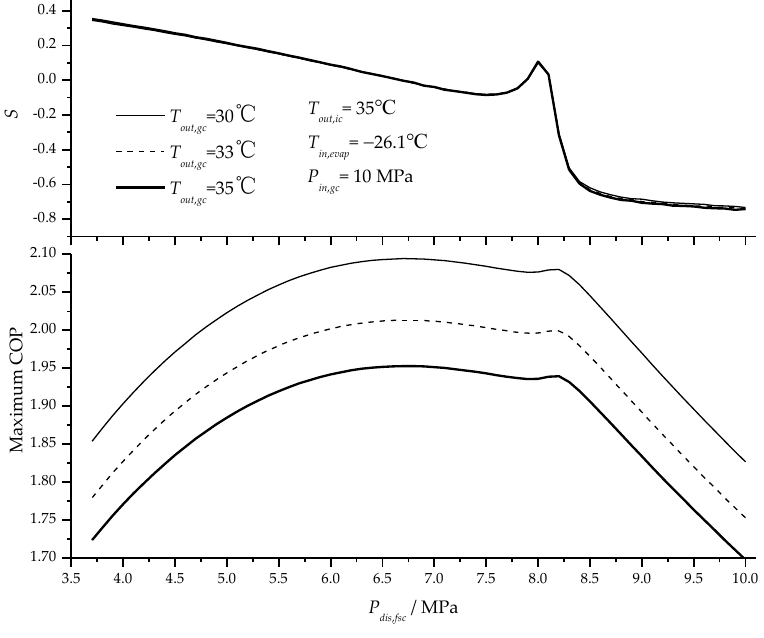
Figure 14. Sensitivity of COP to inter-stage pressure at various gas cooler outlet temperatures.